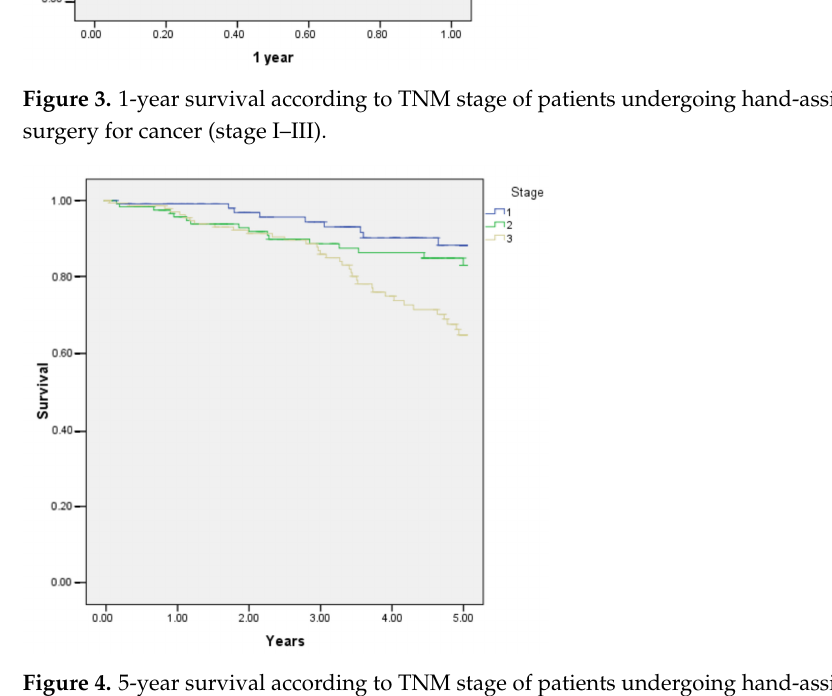
Figure 4. 5-year survival according to TNM stage of patients undergoing hand-assisted laparoscopic surgery for cancer (stage